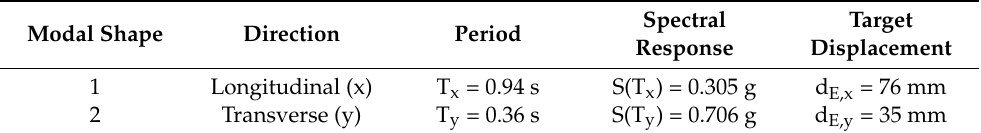
Table 4. Modal parameters for first Case Study bridge, obtained using linear analysis.